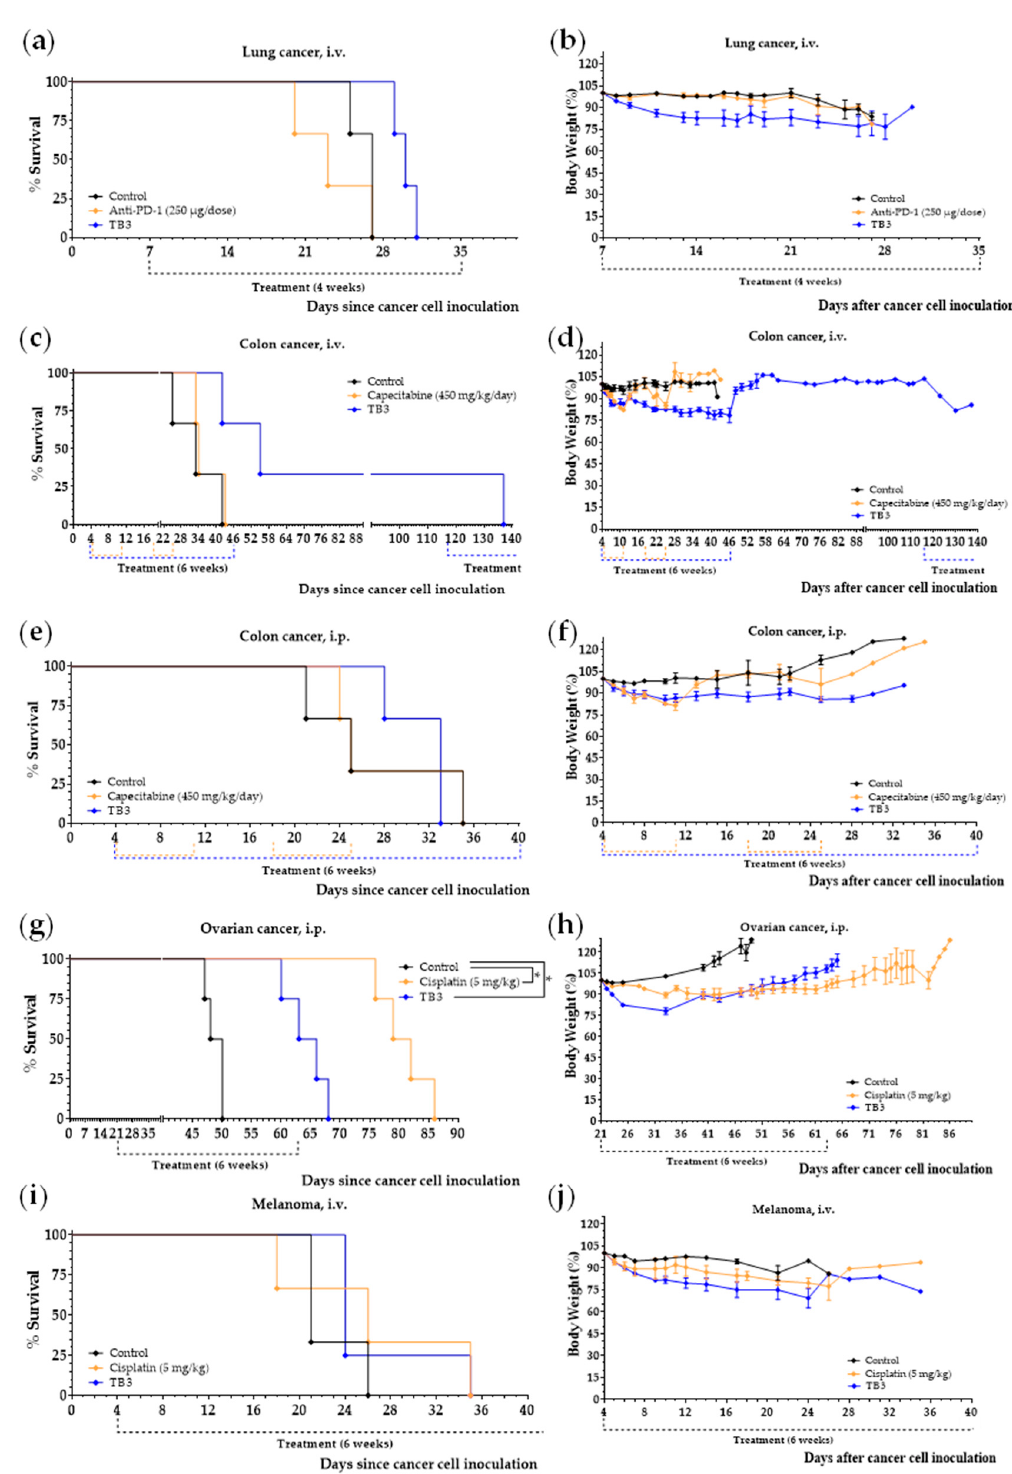
Figure 7. Diet TB3 induces marked anticancer activity in mice with different types of metastatic cancer. Survival of mice left untreated (control), treated with diet TB3 (normal diet was replaced with this diet), or treated with intraperitoneal anti-PD-1 (250 μ g/dose), oral capecitabine (450/mg/day) or intraperitoneal cisplatin (5 mg/kg). Survival ( a , c , e , g , i ) and body weights ( b , d , f , h , j ) of mice with metastatic cancers treated with diet TB3 or a standard anticancer drug. The p -value was calculated with the Gehan–Breslow–Wilcoxon test. See text for further